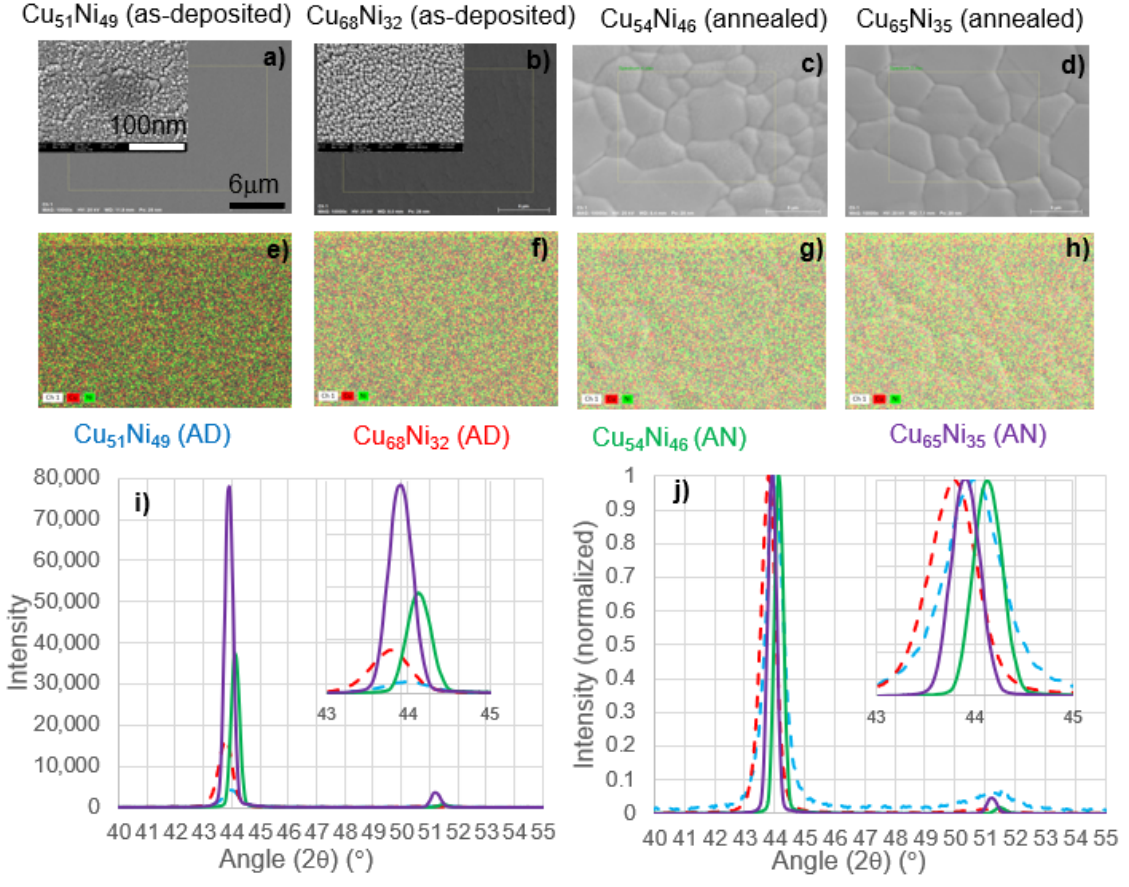
Figure 2. SEM ( a – d ) and EDS maps ( e – h ) and XRD data ( i ), ( j ) of an as-deposited and annealed film region near the equiatomic composition as well as near the optimum bilayer graphene growth composition as will be discussed below.